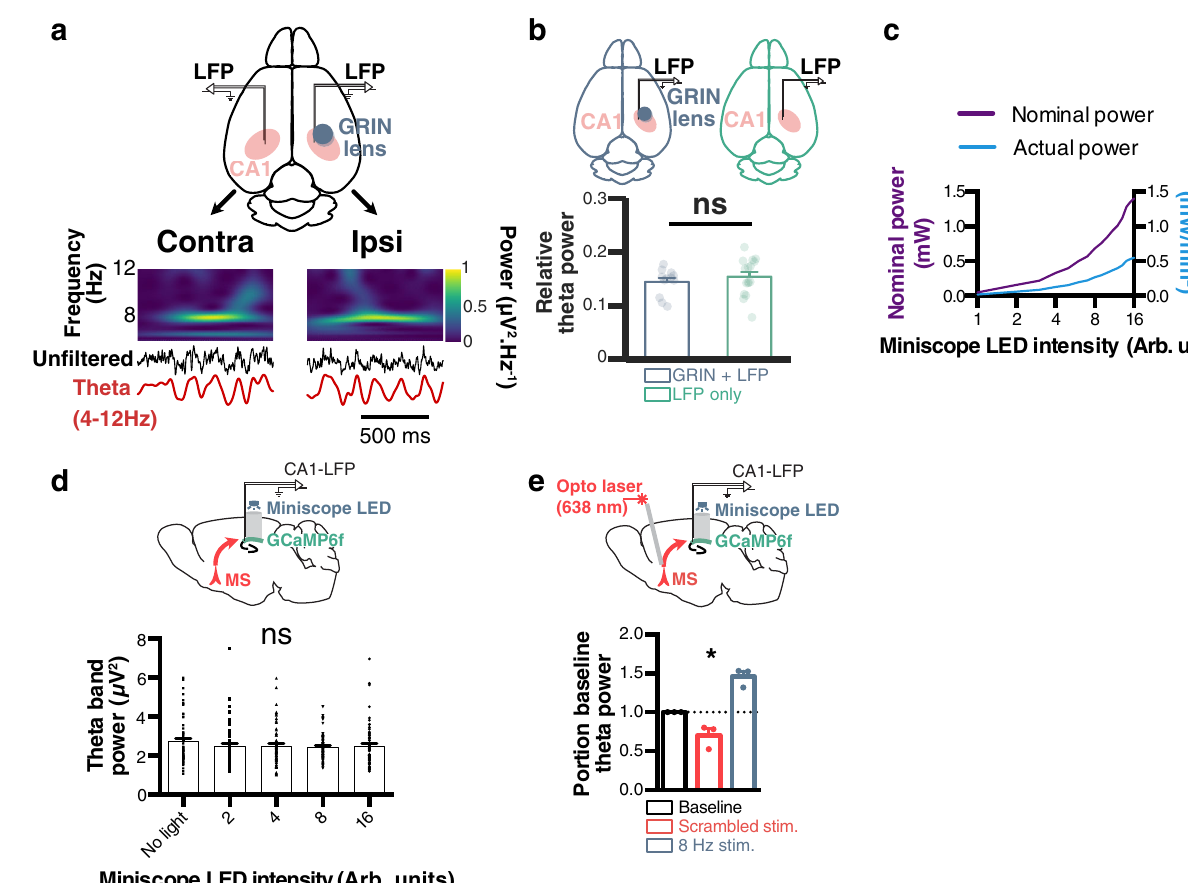
Miniscope LED intensity(Arb. units) Fig. 3 | GRIN lens implant does not affect theta oscillations and enables com- miniscope LED input value and measured nominal power (purple) aswellas actual bined calcium imaging and optogenetics. a Diagram showing recording con fi g- light power corrected for the surface of a GRIN lens (blue). d Corresponding theta power from LFP electrode attached to GRIN lens when using different miniscope uration(horizontalplane),with local fi eldpotential(LFP)electrodesinCA1of both LED emitting light power values in the absence of optogenetic stimulations hemispheres,andaGRINlensonlyintherighthemisphere(top).Forexample,theta (1ANOVA, F 4 =0.7729, p =0.5435; n =60 independent epochs). e Effects of MS oscillations were recorded in both hemispheres using wavelet spectrograms (bot- optogeneticstimulationsonthetaoscillationsduringminiscopebluelightemission tom; dark blue, low power; bright yellow, high power), raw (black), and theta fi l- through the lens (8 Arb. units LED power, corresponding to ~0.3mW/mm 2 ; Fried- tered(red)traces. b Relativethetapowermeasuredintherighthemisphereofmice man test, χ 2 =6.000; p =0.0278; N =3 mice). * p ≤ 0.05; ns not signi fi cant. All bar implantedwithelectrodesandGRINlenses(blue; N =3mice)versuselectrodesonly plots represent the mean±SEM of at least two independent (green; N =4 mice; t -test, t 54 =1.06, p =0.2936). c The relationship between